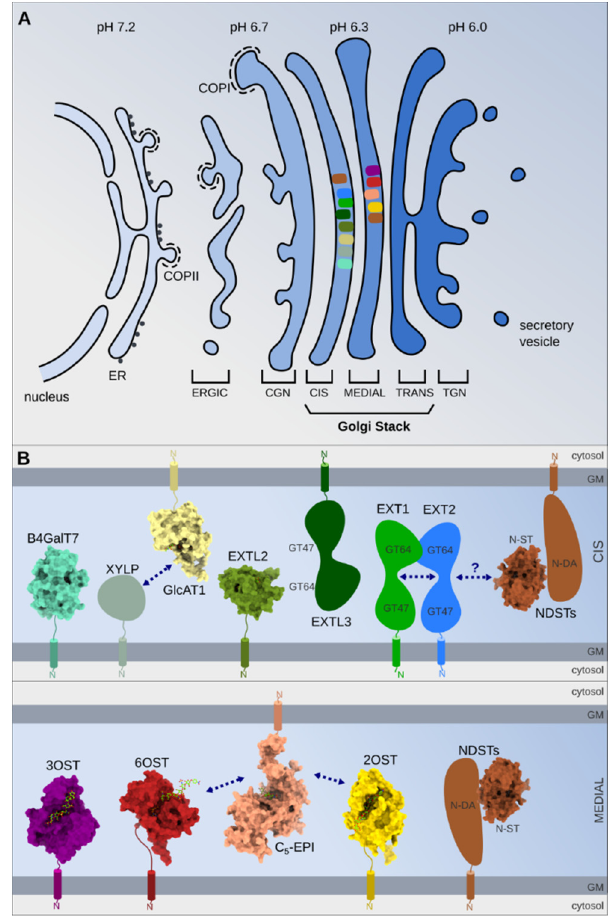
Figure 3. ( A ) Schematic illustrating the Golgi complex. COPII-coated vesicles ensure the protein transport from the endoplasmic reticulum (ER) to the vesicular clusters (ERGIC), which fuse to form the cis-Golgi network (CGN). The Golgi stack is constituted by three separate compartments: the cis- , medial- and trans-cisternae. The last Golgi element, facing the plasma membrane is the trans-Golgi network (TGN). The color change of the ER, ERGIC and Golgi stack reflect the pH gradient. Some enzyme localizations are schematically depicted by different colors corresponding to enzymes represented in part B. Golgi compartmentalization of these enzymes was suggested by using confocal immunocytochemistry and different Golgi markers or Golgi drug treatments (nocodazole, brefeldin A). ( B ) Schematic domain composition of the enzymes involved in HS biosynthesis. Proteins, for which an X-ray crystallography structure has been reported, are shown in surface representation and bound ligands in stick representation. PDB-IDs (B4GalT7: 4IRQ, GlcAT1: 1V84, EXTL2: 10N8, NST: 1NST, 3OST: 3UAN, 6OST: 5T0A, 2OST: 4NDZ, C5-EPI: 6I01). Arrows indicate reported interactions between proteins.